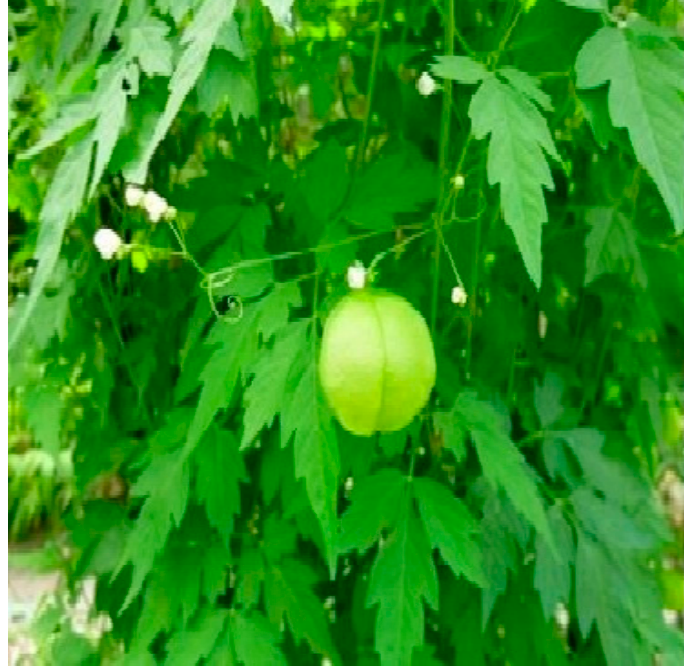
Figure 4. Image of Cardiospermum halicacabum plant. Source: [96].